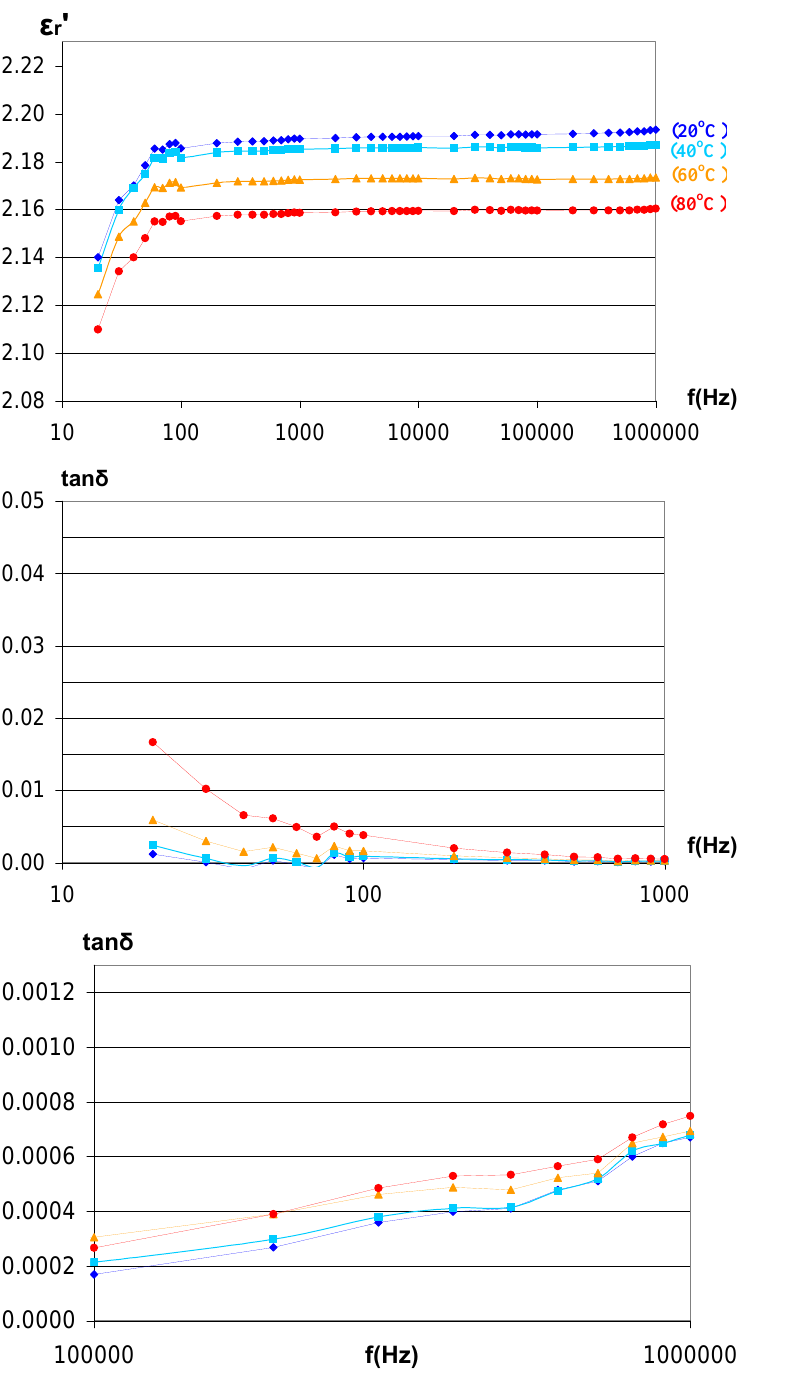
Figure 7. The dielectric spectroscopy data of the 43 power transformer oil samples classified in Group-II. (a) The average values for the relative dielectric constant ( ε ′ ) of all Group-II samples, as a r function of the operating temperature and frequency. (b) The average values of all loss tangent (tan δ ) data of the Group-II samples, as a function of operating temperature in the frequency range: 20Hz – 1kHz. (c) The average values of all loss tangent (tan δ ) data of the Group-II samples, as a function of operating temperature in the frequency range: 100kHz –